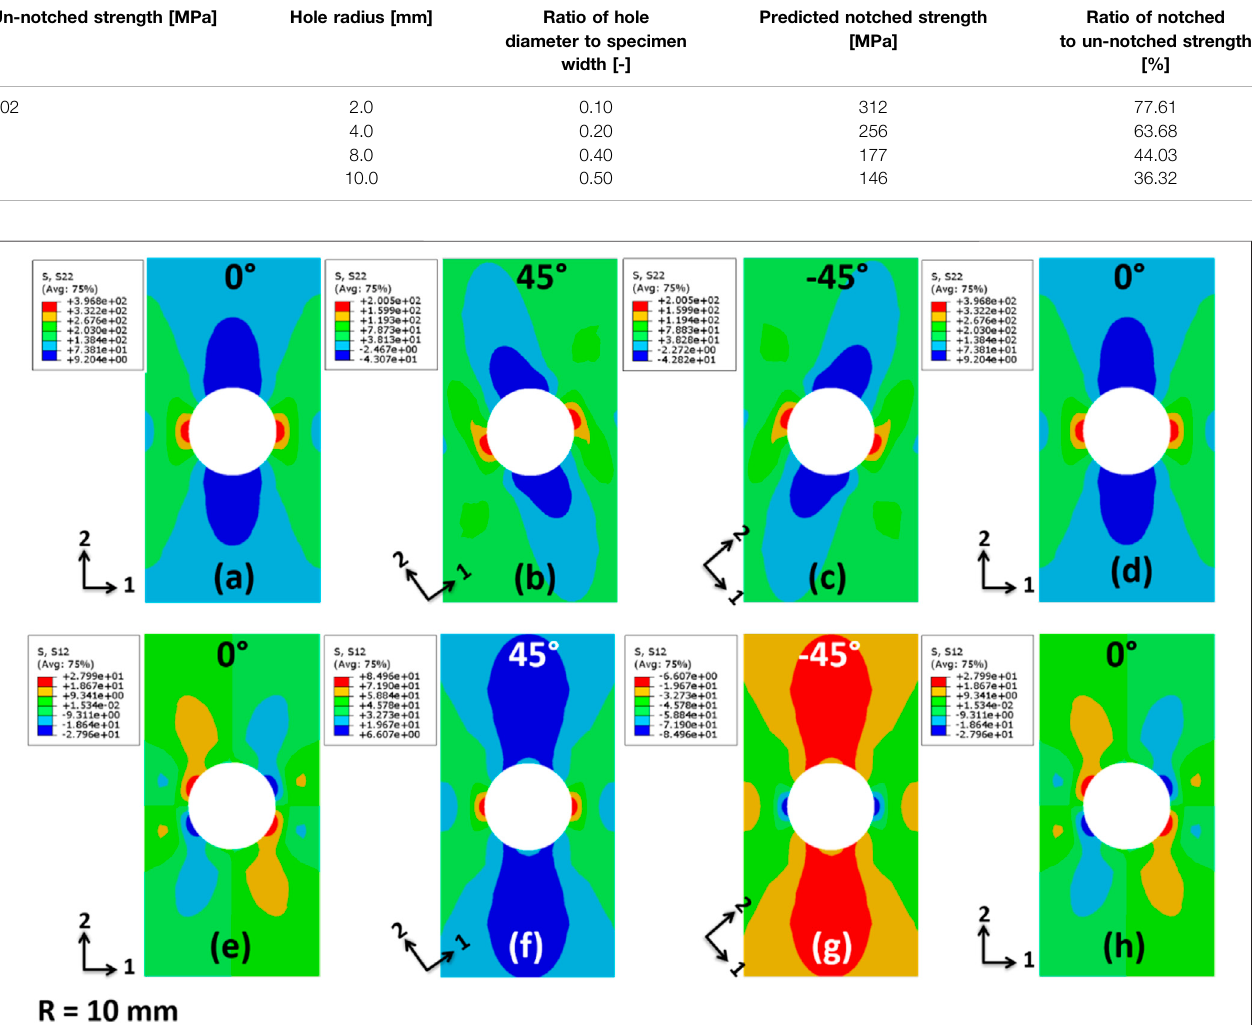
TABLE 6 | Predicted results of the notched woven SiC f /SiC composite sample: the sample ’ s width is 40 mm. Un-notched strength [MPa]